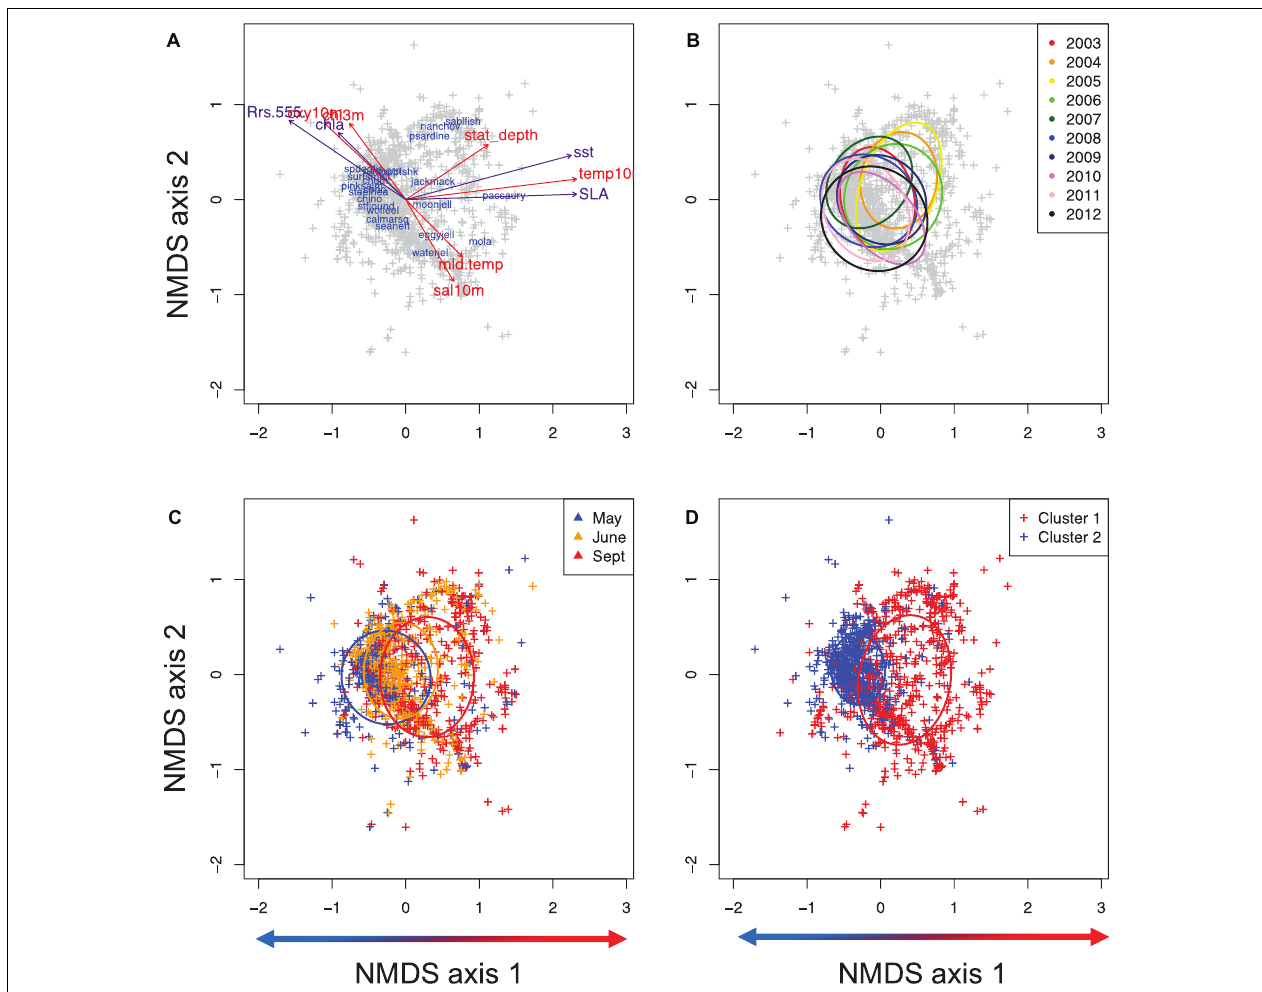
FIGURE 2 | Non-metric Multidimensional Scaling (NMDS) ordination plots of all stations sampled between 2003 and 2012. (A) species centroid overlay with environmental vector overlay, (B) stations colored by year, (C) stations colored by month, (D) Cluster 1: warm vs. cluster 2: cold community clusters. Arrows along axis 1 represent temperature gradient along axes from cold on the left to warm on the